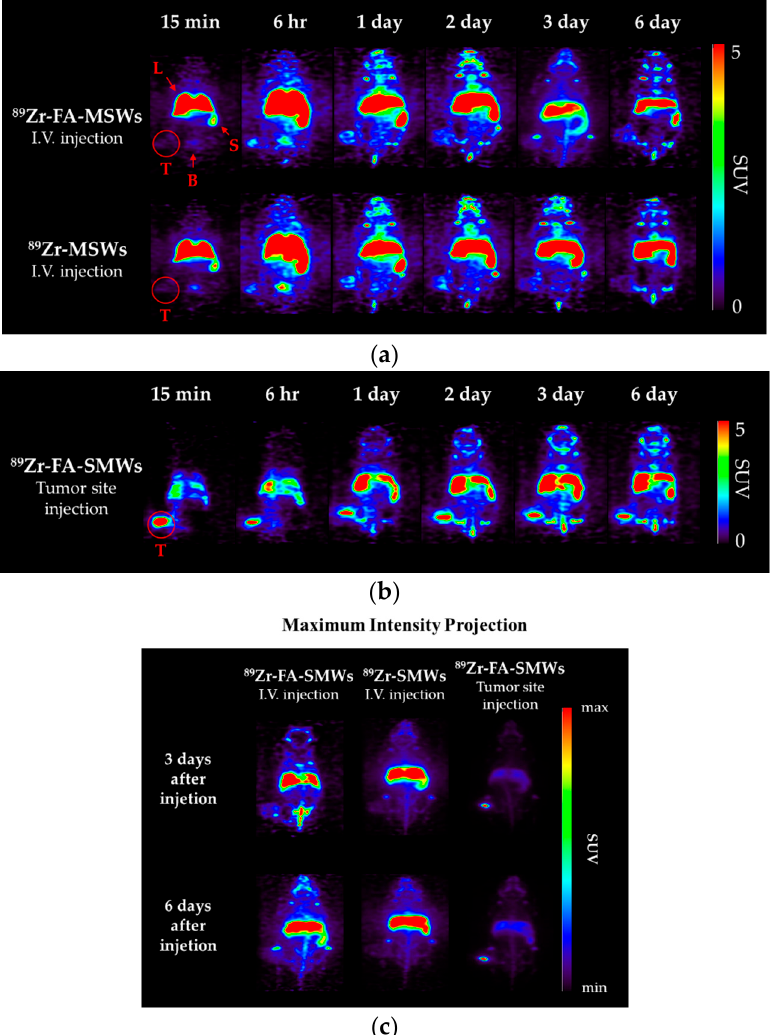
Figure 9. Positron emission tomography (PET) images of CT-26-bearing female Balb/c mice (5 weeks). Mice were scanned using a 5 min static mode at time points after ( a ) intravenous injection of 89 Zr-FA-SMWs and 89 Zr-SMWs, ( b ) tumor site injection of 89 Zr-FA-SMWs and ( c ) maximum intensity projection (MIP) images.